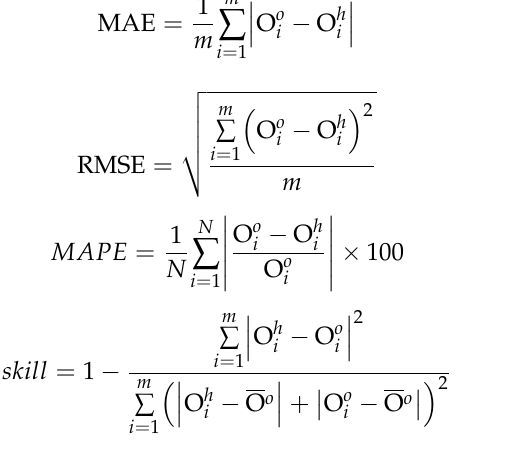
Figure 6. Typhoon tracks for each category during the period 1978–2017. ( a – i ) are corresponding to C1–C9.